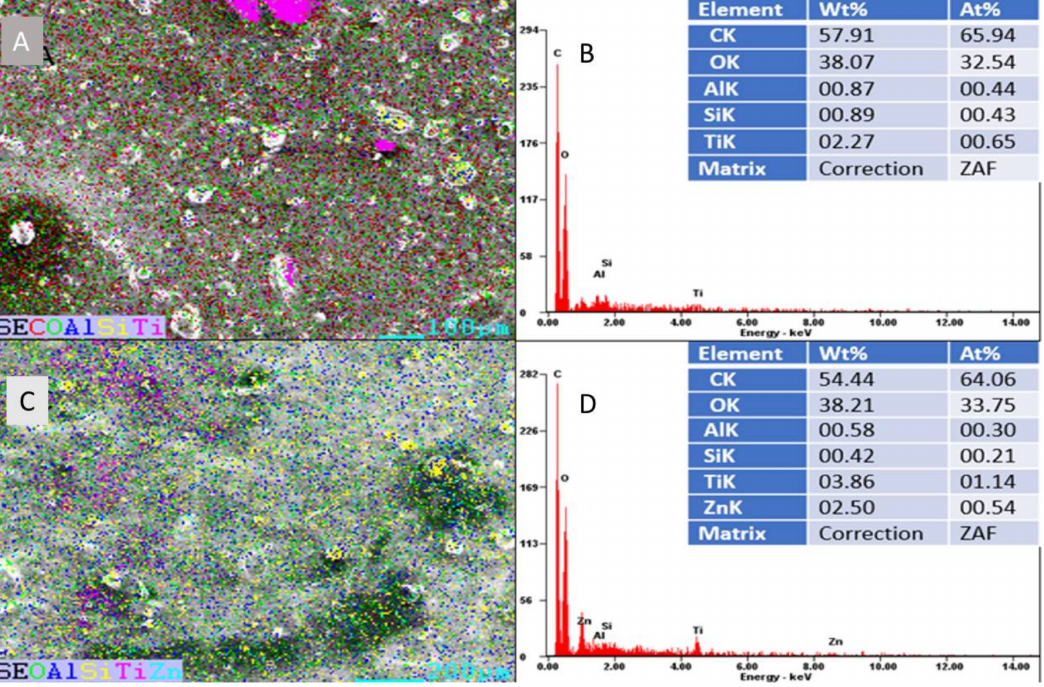
Figure 4. EDS mapping of ( A , B ) CS-HNTs and ( C , D ) CS-ZnHNTs; a more uniform surface with less titanium base metal visibility was obtained, which could be due to the increased conductance of the electrophoretic deposition upon the addition of